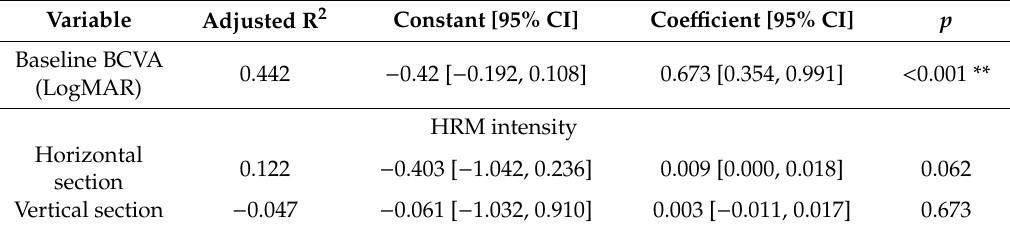
Table 3. Univariate linear regression analysis for BCVA at month